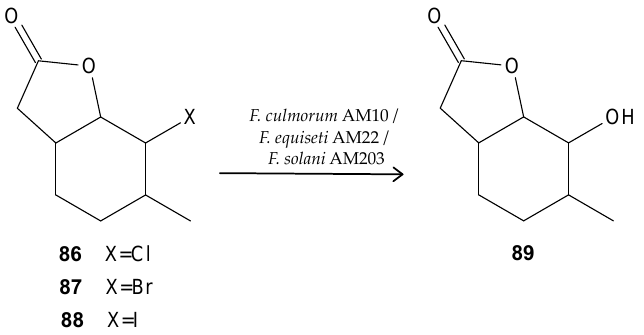
Figure 12. Lactones 86 – 89 .